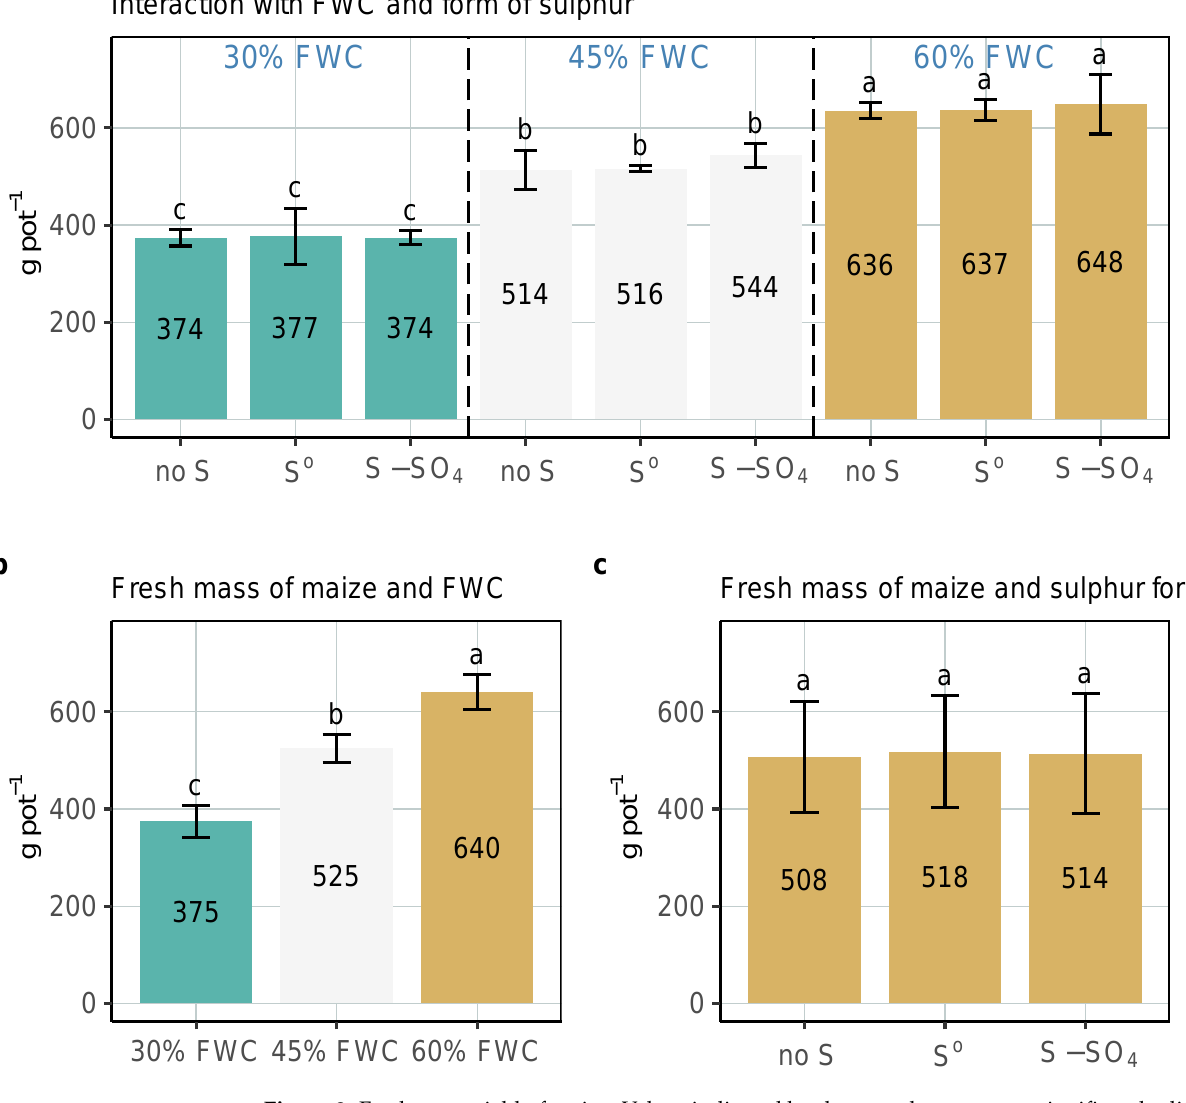
Figure 3. Fresh mass yield of maize. Values indicated by the same letter are not significantly different ( α =